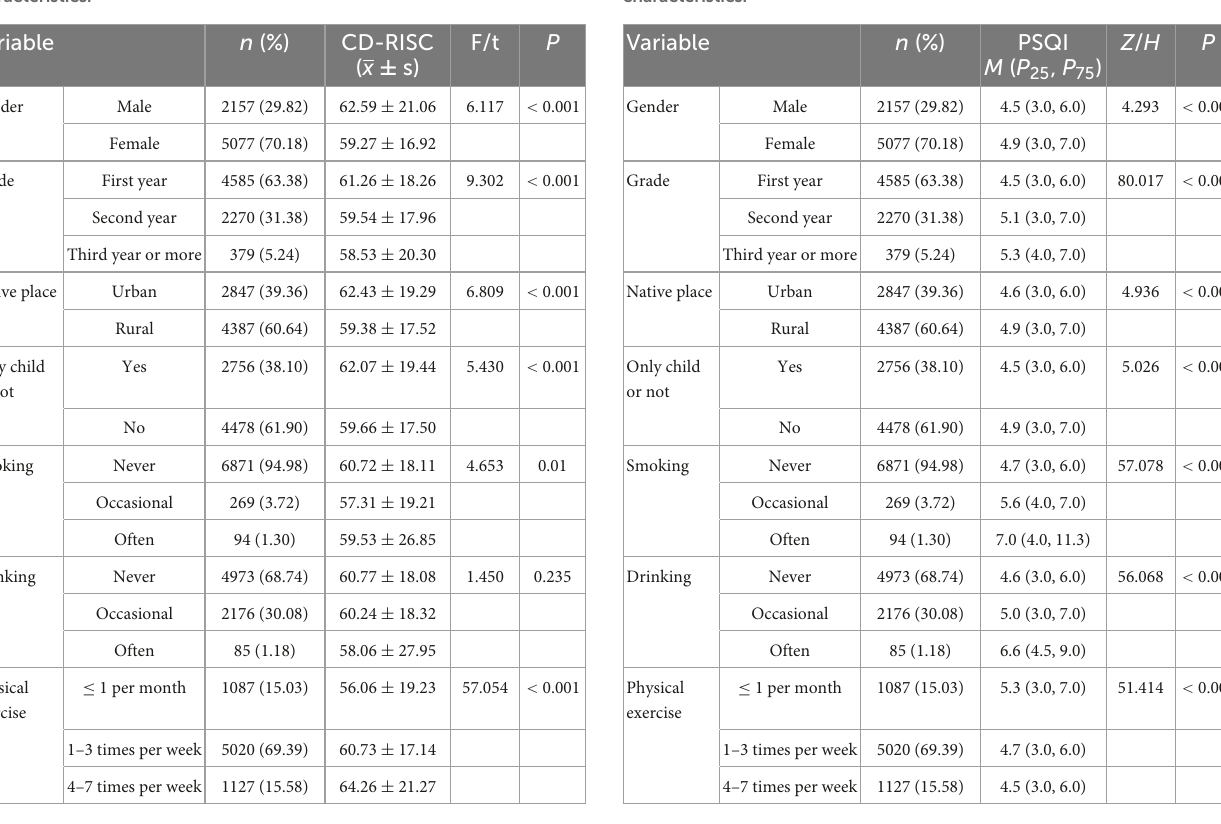
TABLE 3 Sleep quality scores of college students with different characteristics.